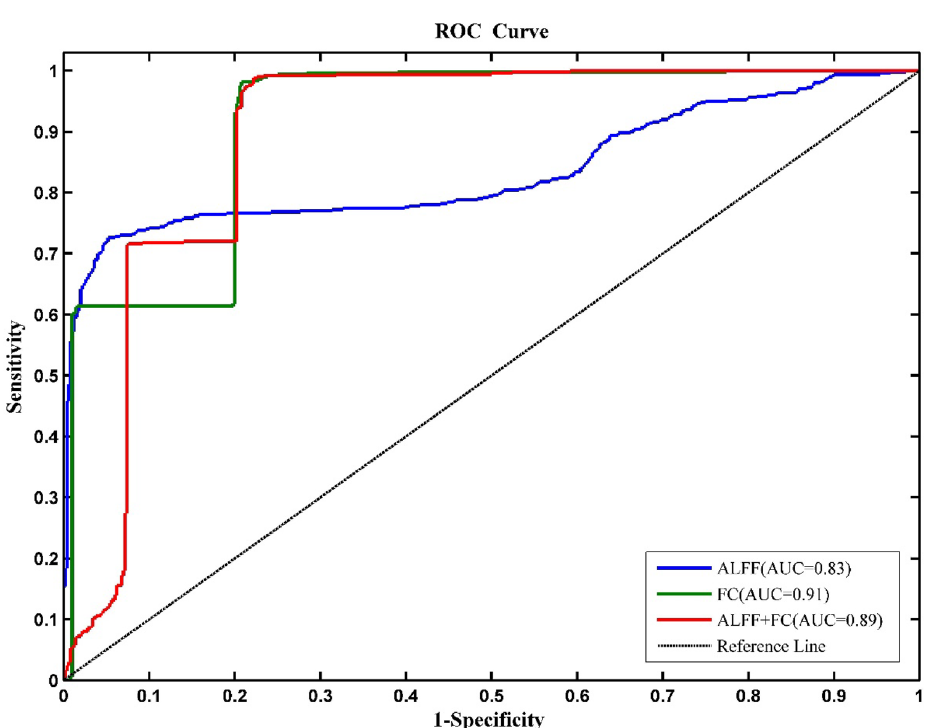
Figure 1. ROC curves of LR models based on different features for classification of CI patients and